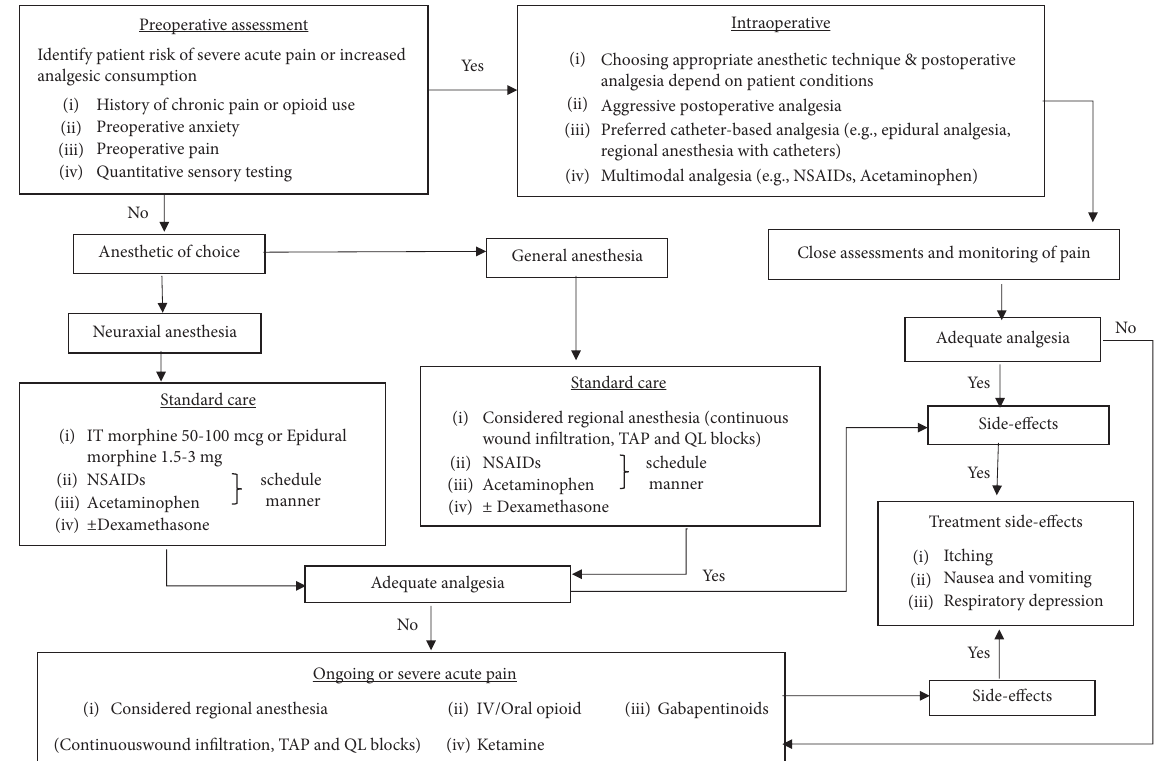
Figure 1: Stepwise multimodal analgesia for postcesarean delivery pain